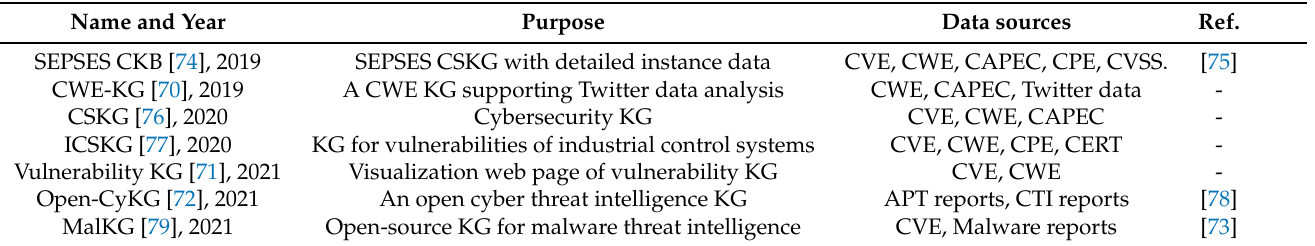
Table 1. Comparative table of the datasets of open-source